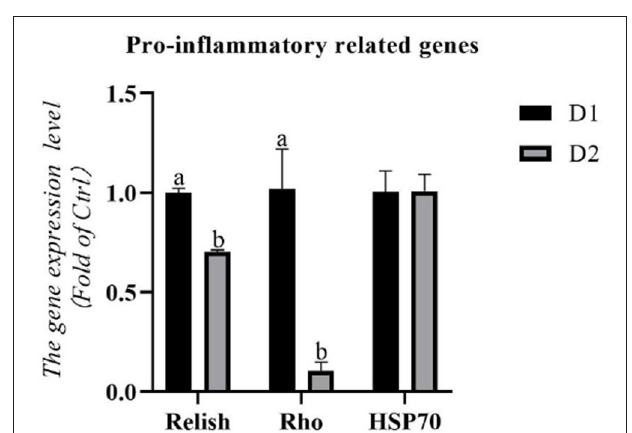
FIGURE 2 | Hepatopancreas RNA expression levels of pro-inflammatory related genes of L. vannamei fed diets supplemented with/without Klebsormidium sp. for 56 days. a , b The small letters indicated significant differences at p < 0.05.